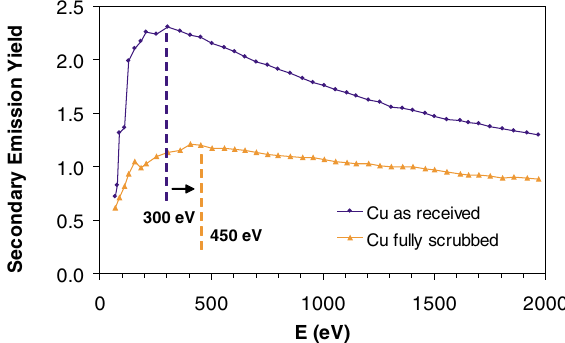
FIG. 2. (Color) SEYas a function of the electron energy for an ‘‘as received’’ copper surface (upper curve) and that surface after intense electron bombardment (lower curve). After elec- occurs at higher tron bombardment, SEY is lower and SEY max electron energies. Courtesy of M. Pivi (Ref. [2]).